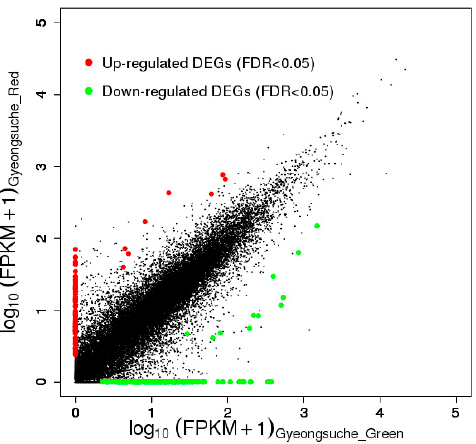
Figure 2. Gene expression levels of green and red mizuna. The differentially expressed genes are shown in red and green, and genes without expression changes are shown in black (false discovery rate (FDR) < 0.05). Table 1. Gene ontology terms ( p -value and fold enrichment) that were significant in the enrichment analysis in the gene list from the red vs. green mizuna cultivar comparison.